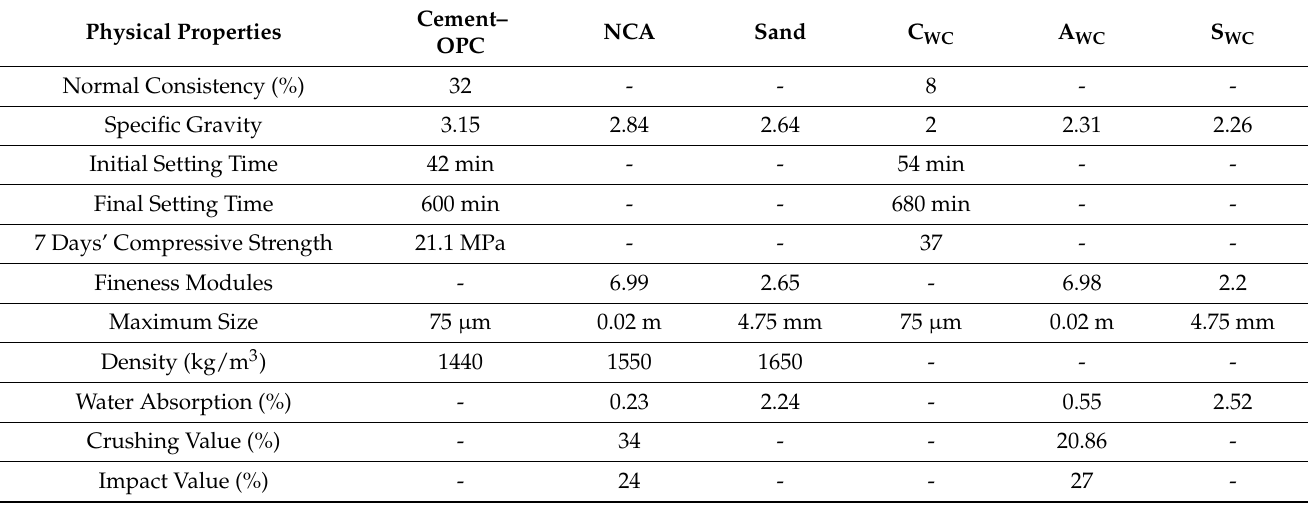
Table 1. Properties of used materials.